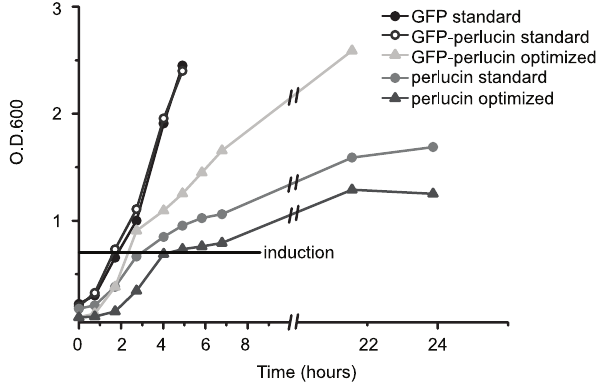
Figure 1. Cell density profiles for recombinant GFP, GFP- perlucin and perlucin expressing E.coli cultures. Standard culture conditions (circles) are suitable with respect to both, cell growth and protein yield for GFP (black line, closed circles). Despite the fast growth rate of GFP-perlucin cells under standard conditions (black line, open circles), the final protein yield is low (Figure 2B). When these cells are cultivated using the optimized temperature profile, cell densities reach an O.D. (optical density) of , 2.6 after 22 hours (light grey triangles) and protein yields increase (Figure 2C). Perlucin expressing cells divide slower under both, standard (grey circles) and optimized (dark grey triangles) growth conditions to a maximum O.D. of 1.6 after 24 hours, suggesting a possible toxic effect of perlucin on cell proliferation. Regardless of culture conditions, recombinant perlucin can hardly be purified natively (Supporting Information file Figure